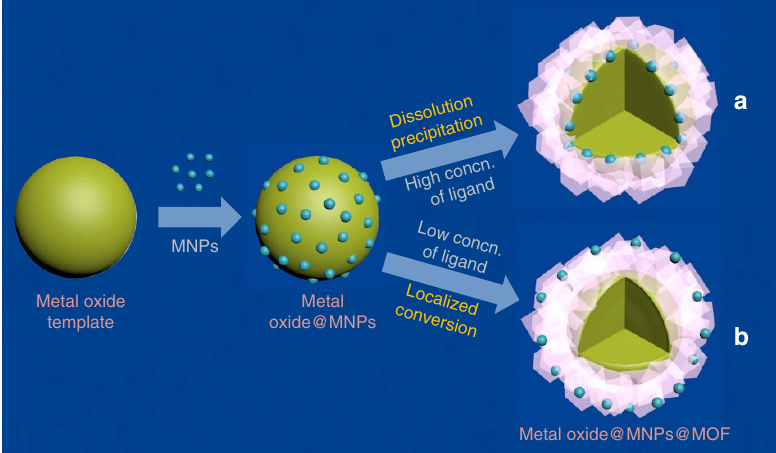
Figure 1 | Spatial localization regulation of MNPs within MOF crystals via template-sacrifice method. Through surface modification with surfactant PVP, MNPs of various sizes, shapes and compositions are loaded on the surface of metal oxide, and by reacting the metal oxide/MNPs template with organic ligands, MNPs can be encapsulated in MOF crystals. The spatial distribution of incorporated MNPs within MOF crystals can be controlled by tuning the crystallization behaviour of MOFs under ( a ) high and ( b ) low concentration of the organic